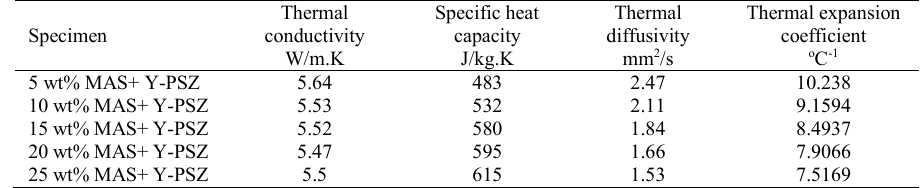
Table 2. Thermal conductivity, Specific heat capacity, Thermal diffusivity and Thermal expansion coefficient values of Y-PSZ with different MAS Thermal Specimen conductivity W/m.K